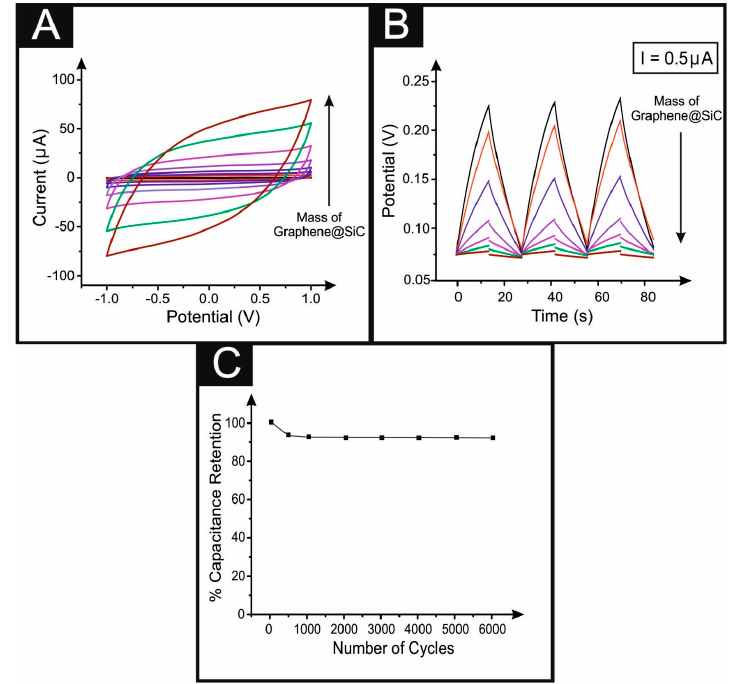
Figure 2. Cyclic voltammograms ( A ) and charge-discharge curves ( B ) of increasing masses of graphene@SiC in a 0.1 M H 2 SO 4 aqueous solution. Original capacitance retention percentage vs. charge-discharge number of cycles apply ( C ).